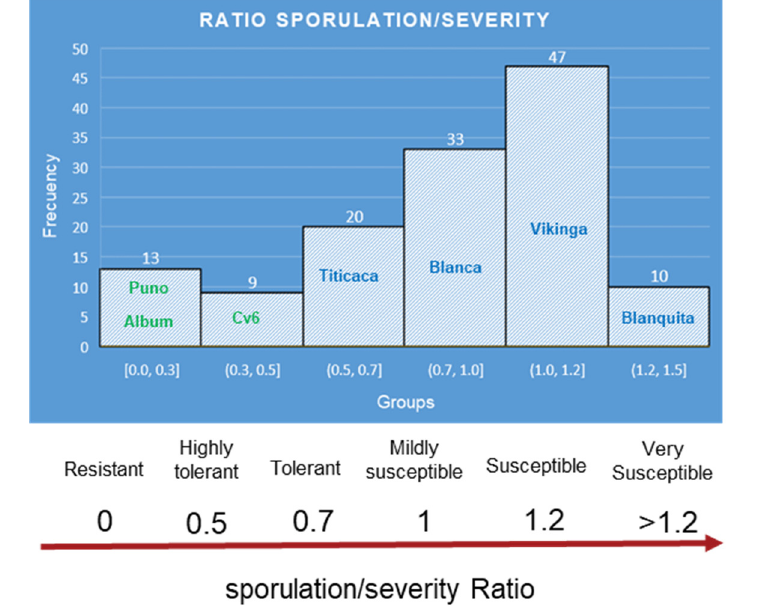
Figure 10. Ratio calculated from mean averages of sporulation/severity for the South American diversity panel. The names inside the histogram bars correspond to reference and representative cultivars for each group. Source: calculated with the data set from Colque-Little et al. (2021)